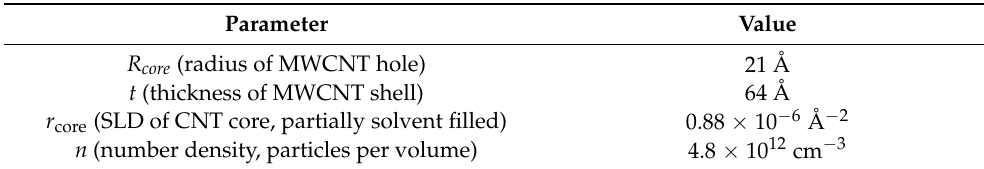
Table 5. Parameters obtained from fitting the core–shell cylinder model to the data of 0.5 wt.%